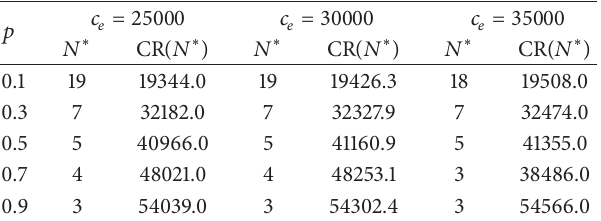
Table 5: Sensitivity analysis for 𝑐 𝑒 .